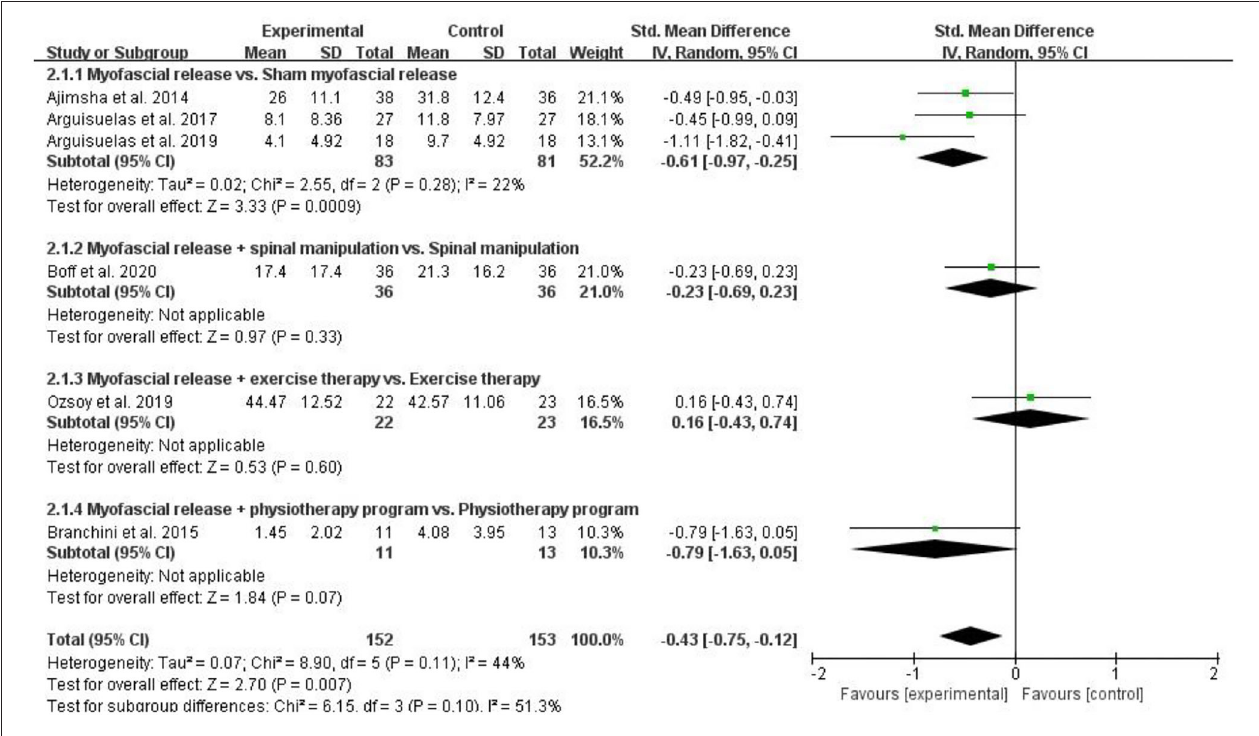
FIGURE 4 | Meta-analysis on physical function.